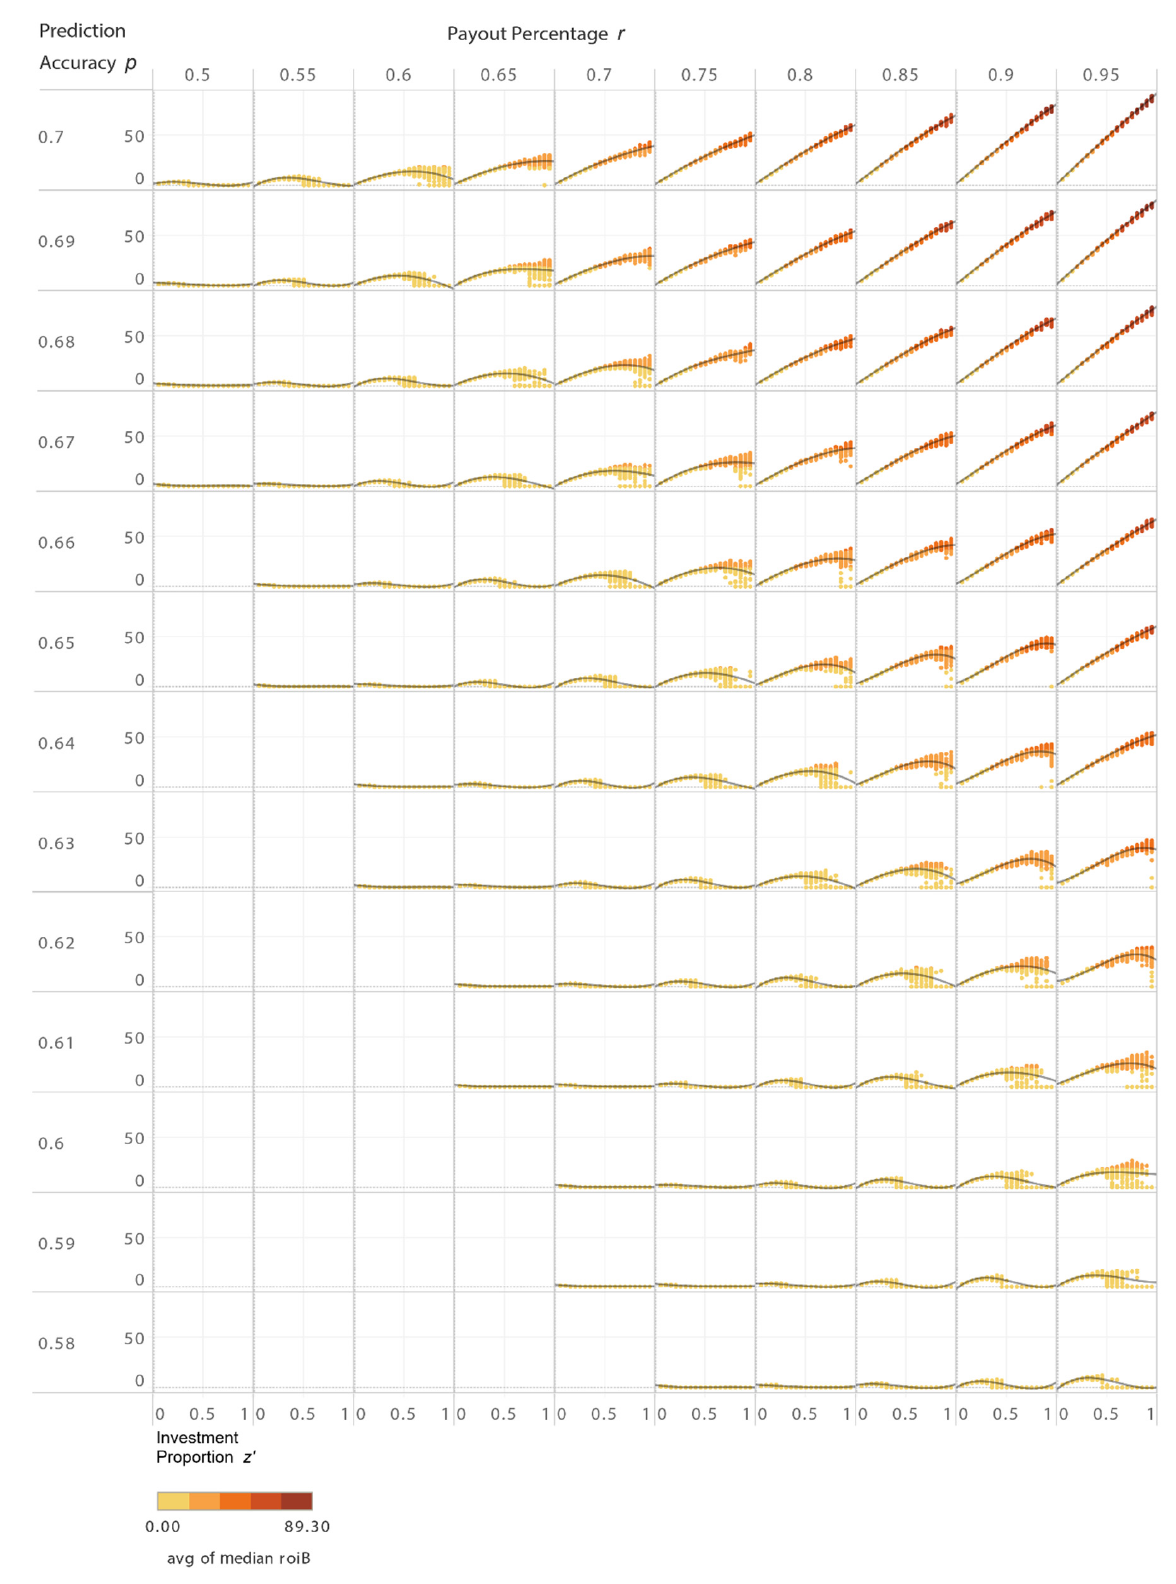
Figure 9. Impact of prediction accuracy 𝑝 , payout percentage 𝑟 , and investment proportion 𝑧′ on (average of median) 𝑟𝑜𝑖𝐵 for Strategy B.